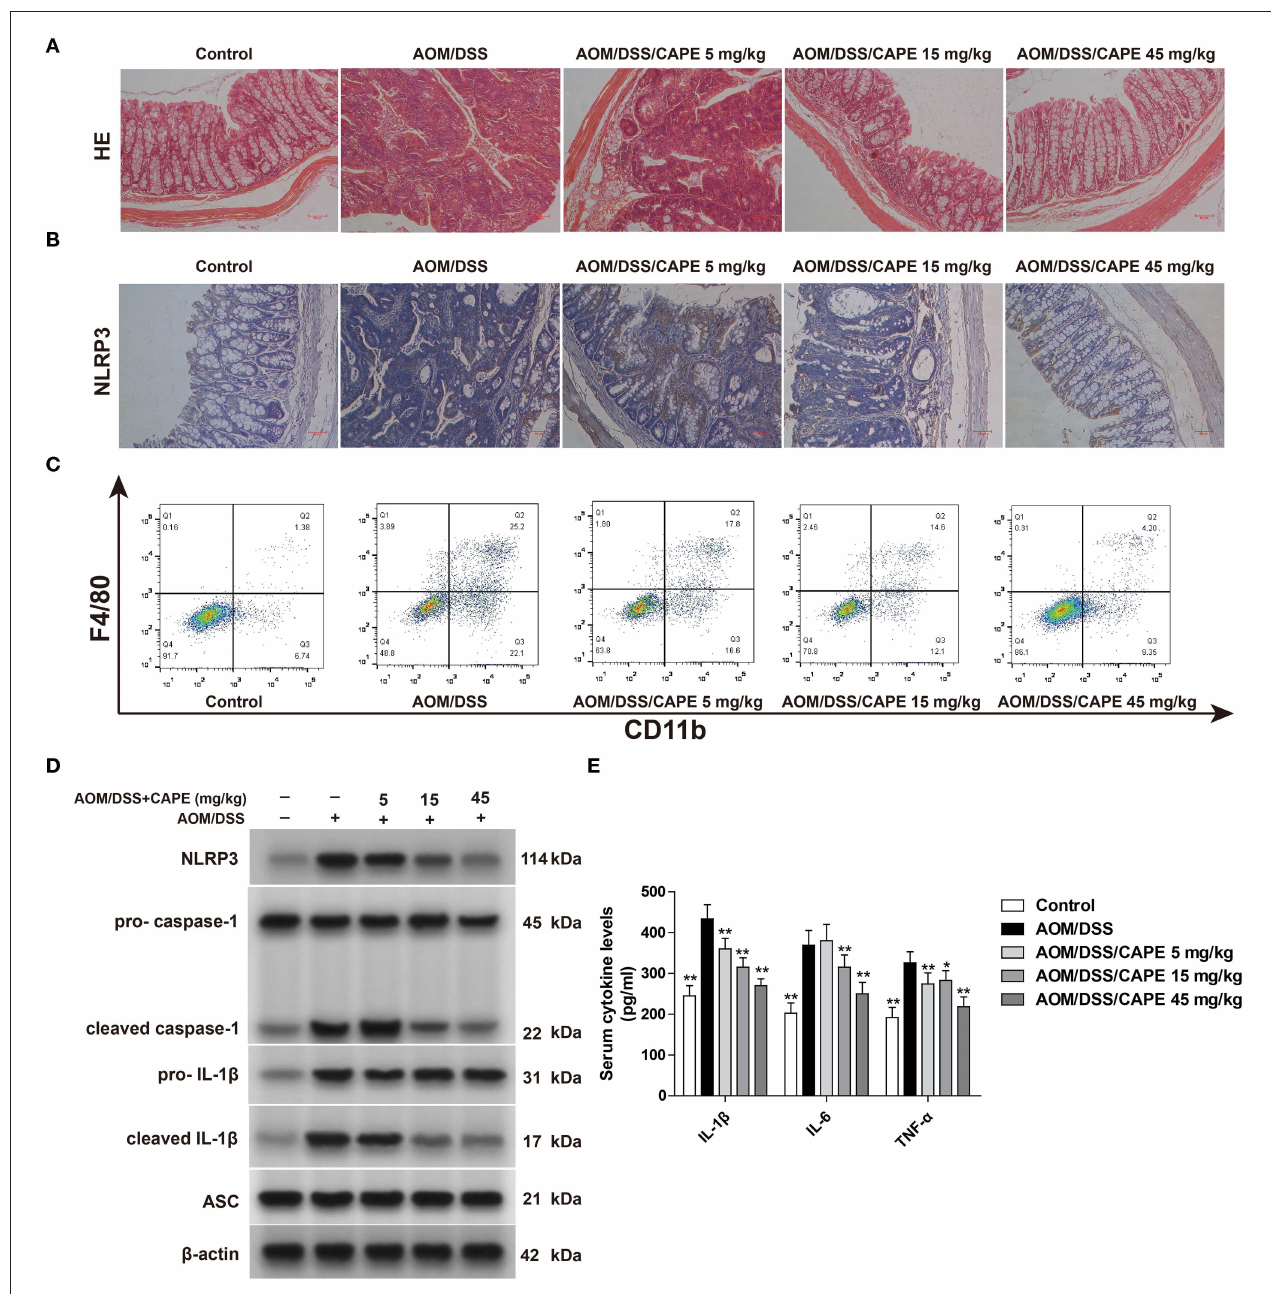
FIGURE 5 | NLRP3 inflammasome inhibition contributes to the anti-tumor effect of CAPE. (A) Colon tissues were fixed and stained with hematoxylin-eosin. (B) Immunohistochemistry of NLRP3 in the colon. (C) F4/80 + CD11b + macrophages in infiltrated leukocytes of colon tissue were detected by FACS blots. (D) Western blotting for NLRP3, pro-caspase-1, cleaved caspase-1, pro-IL-1 β , cleaved IL-1 β , and ASC in colons. (E) ELISA for IL-1 β , IL-6, and TNF- α in serum. Data are represented as mean ± SD ( n = 3). * P < 0.05, ** P < 0.01 vs. AOM/DSS group. Scale bar = 50 µ m.